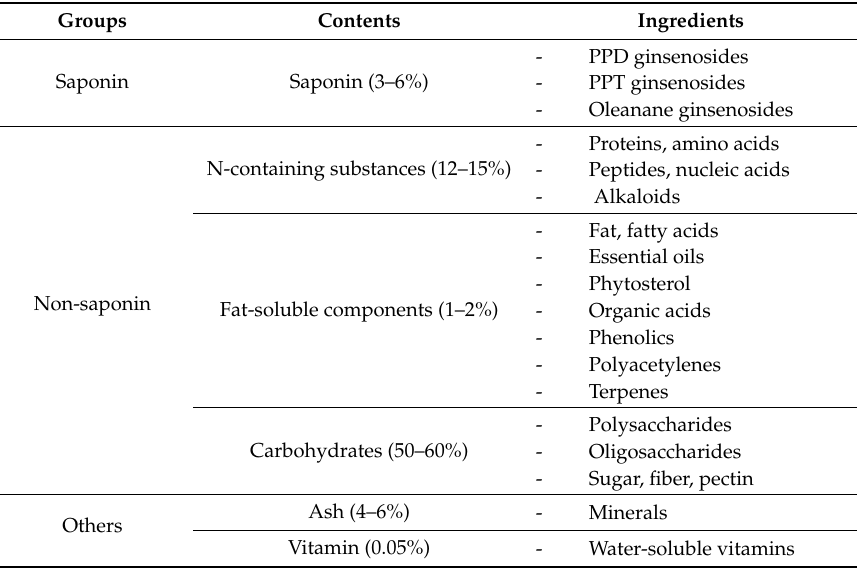
Table 1. Chemical constituents of Korean ginseng.